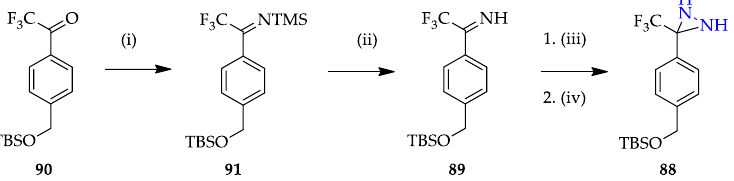
Figure 12. Synthesis of diaziridine 91 via unconventional reagents in an ammonia-free method. Reagents: (i) LiN(TMS) 2 in THF, toluene; (ii) methanol; (iii) p -toluenesulfonyl hydroxylamine in THF; (iv) piperidine.